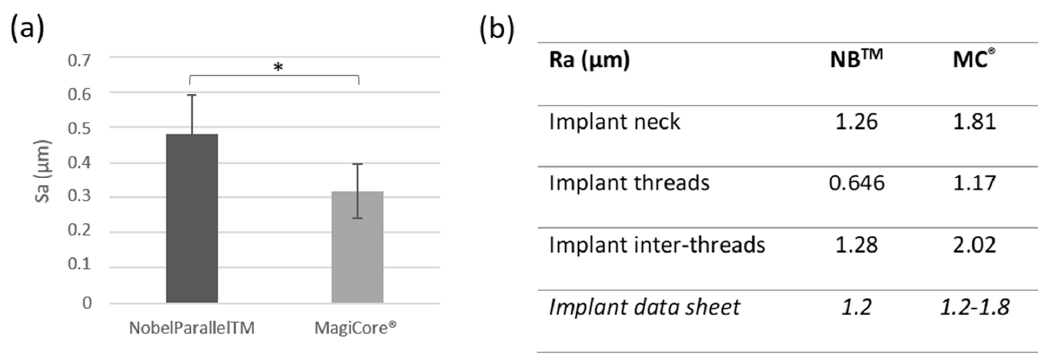
Figure 2. Surface roughness. ( a ) Arithmetical mean height (Sa) (n = 5 ± SD, * p < 0.05) and ( b ) Arithmetic roughness average (Ra).